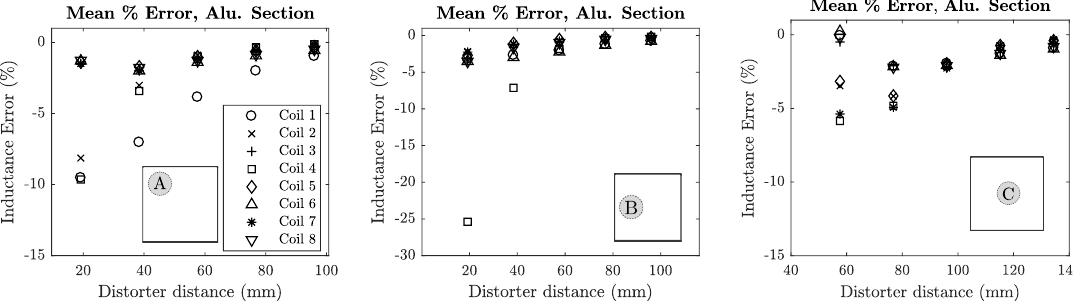
Figure 13. Mutual inductance error for the small aluminium block distorter in locations A, B and C. It can be seen that the location of the distorter decreases the mutual inductance of the coils in closest